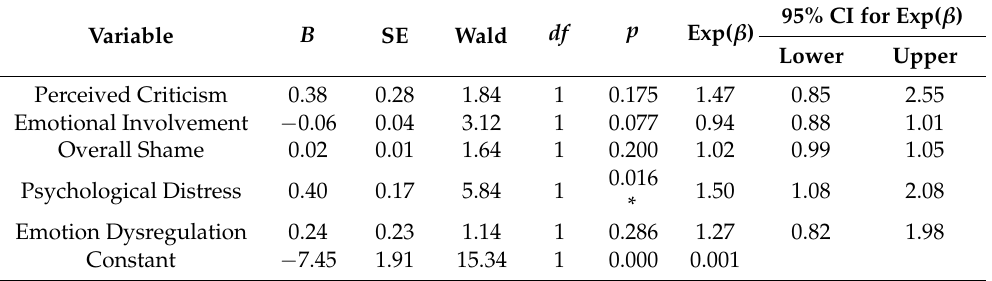
Table 3. Logistic regression predicting likelihood of self-injury